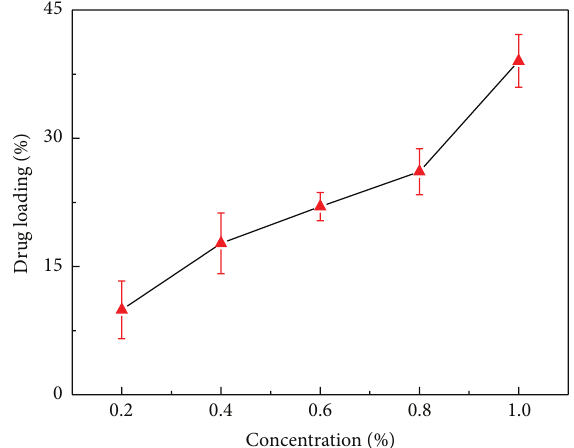
Figure 5: Ibuprofen loading in chitosan hydrogel by immersing titanium plates in various concentrations of ibuprofen.